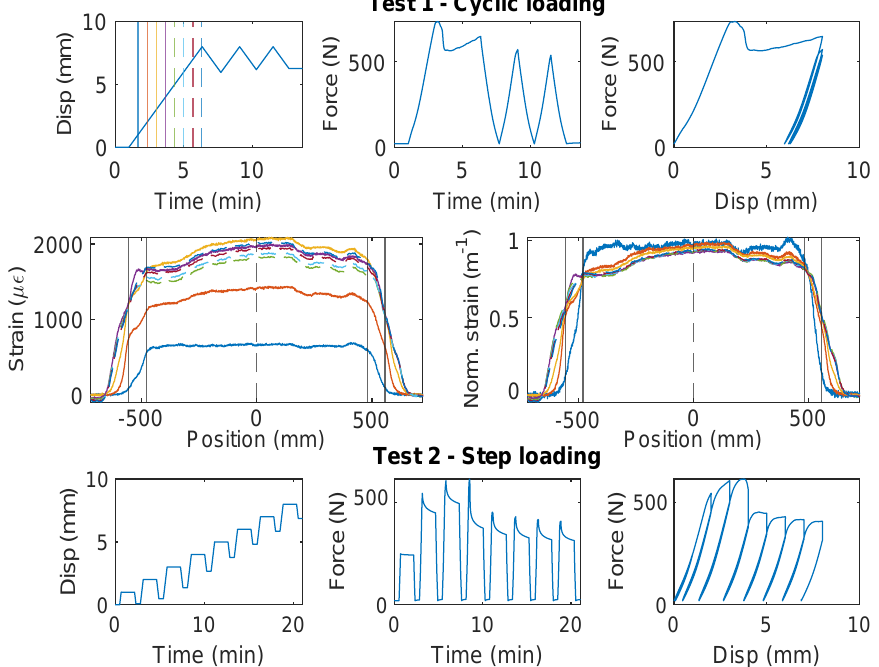
Figure 12. The loading protocol, force–displacement relation and strain distributions under increasing displacement levels (represented by different color lines) for Specimen 1 of the Stranded Steel 5.0 mm